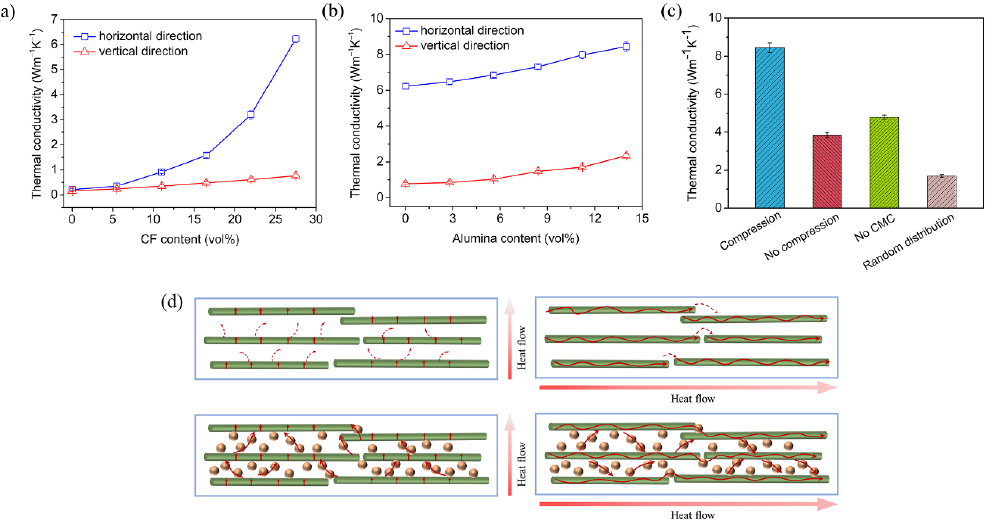
Figure 7. ( a ) The dependence of the thermal conductivities of the PDMS/CF composites in the hori- zontal and vertical directions on the CF content when the alumina content was 0, ( b ) the dependence of the thermal conductivities of the PDMS/alumina/CF composites in the horizontal and vertical directions on the alumina content when the CF content was 27.5 vol%, ( c ) a comparison of the thermal conductivities in the horizontal direction of the PDMS/alumina/CF composite, the composite without compression, the composite without CMC and the composite with a randomly distributed filler at the same content of 27.5 vol% CF and 14.0 vol% alumina, ( d ) the thermal conduction mechanisms of the PDMS/CF and PDMS/alumina/CF composites.